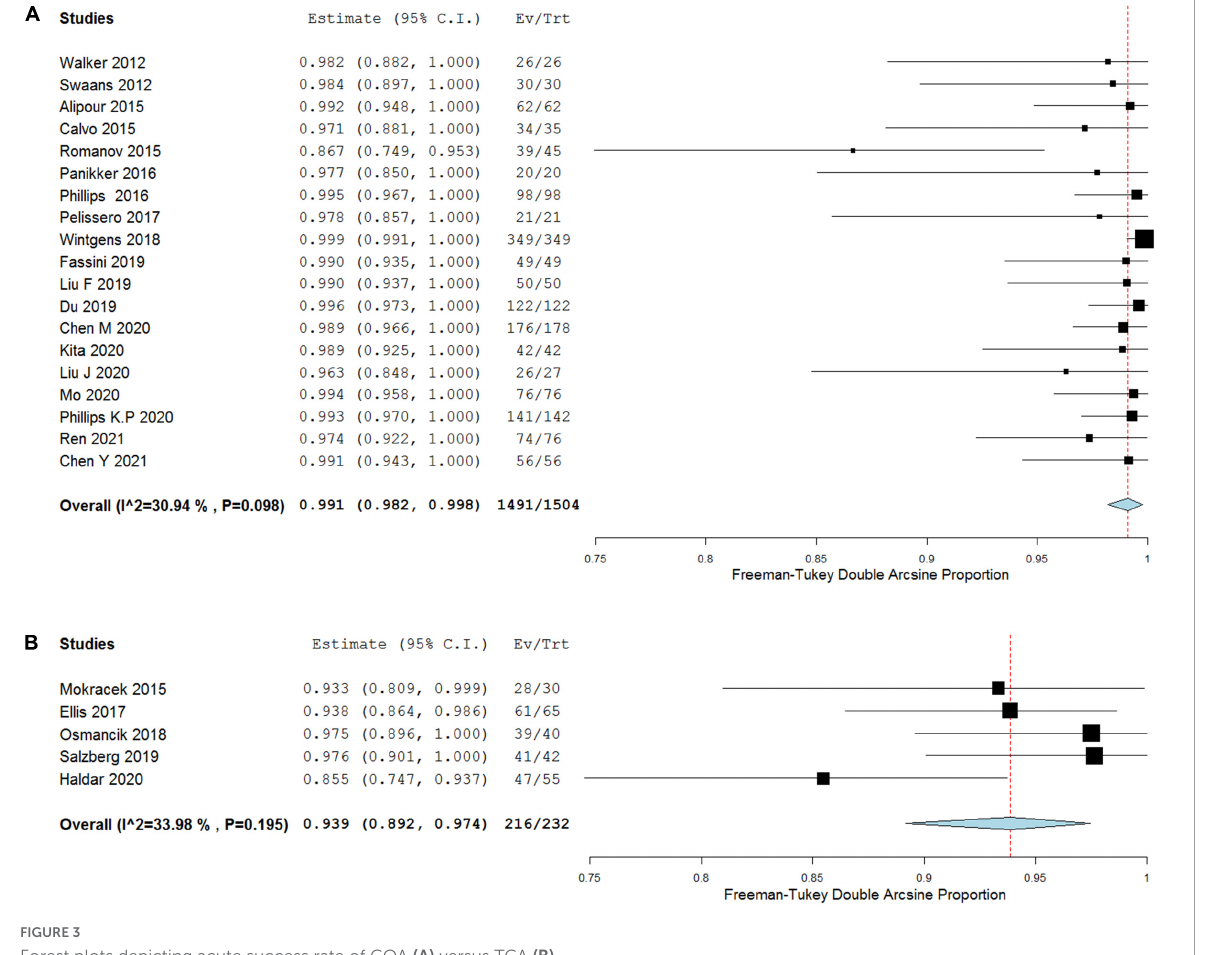
FIGURE3 Forest plots depicting acute success rate of COA (A) versus TCA (B)